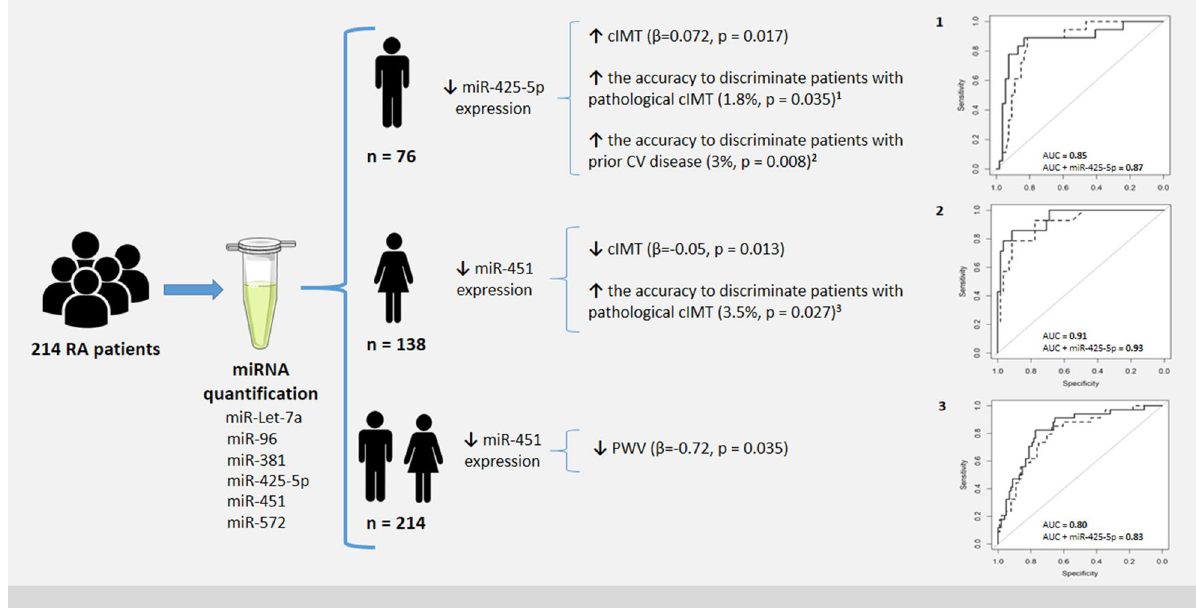
Figure 5. Overview of the main results of the